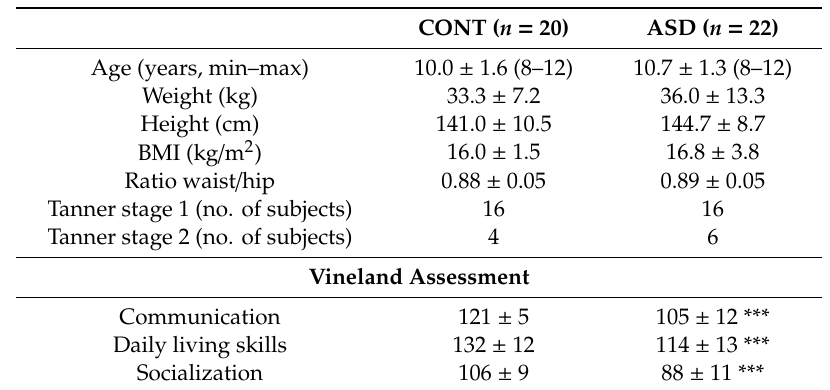
Table 1. Participant’s anthropometric characteristics and Vineland